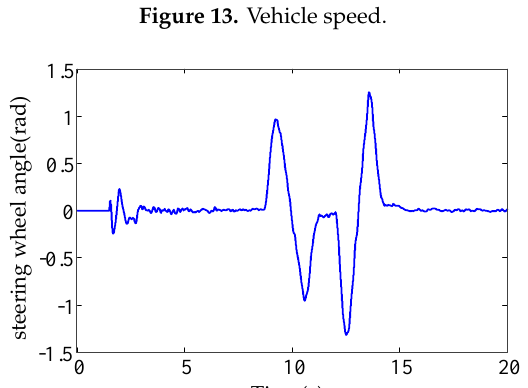
Figure 14. Vehicle steering wheel angle.